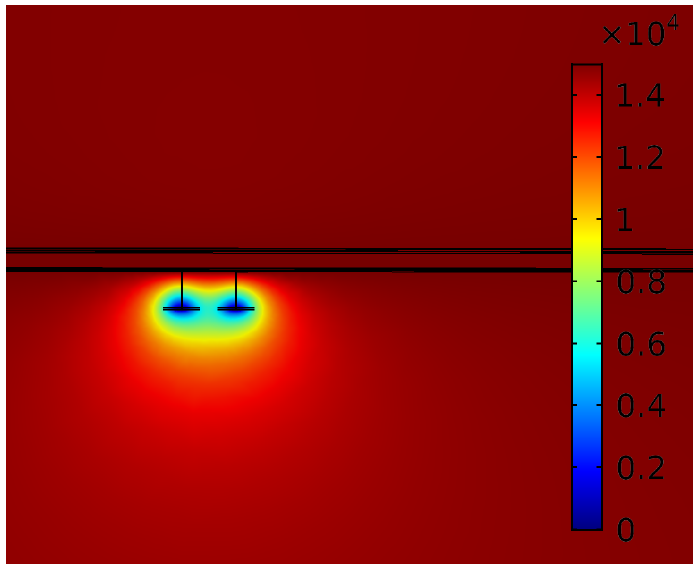
Figure 5. An example result of FEM simulation of an electric field potential “low (cid:101) ” case. Sensor electrodes were assumed at zero potential for capacitance calculation. Scale values in